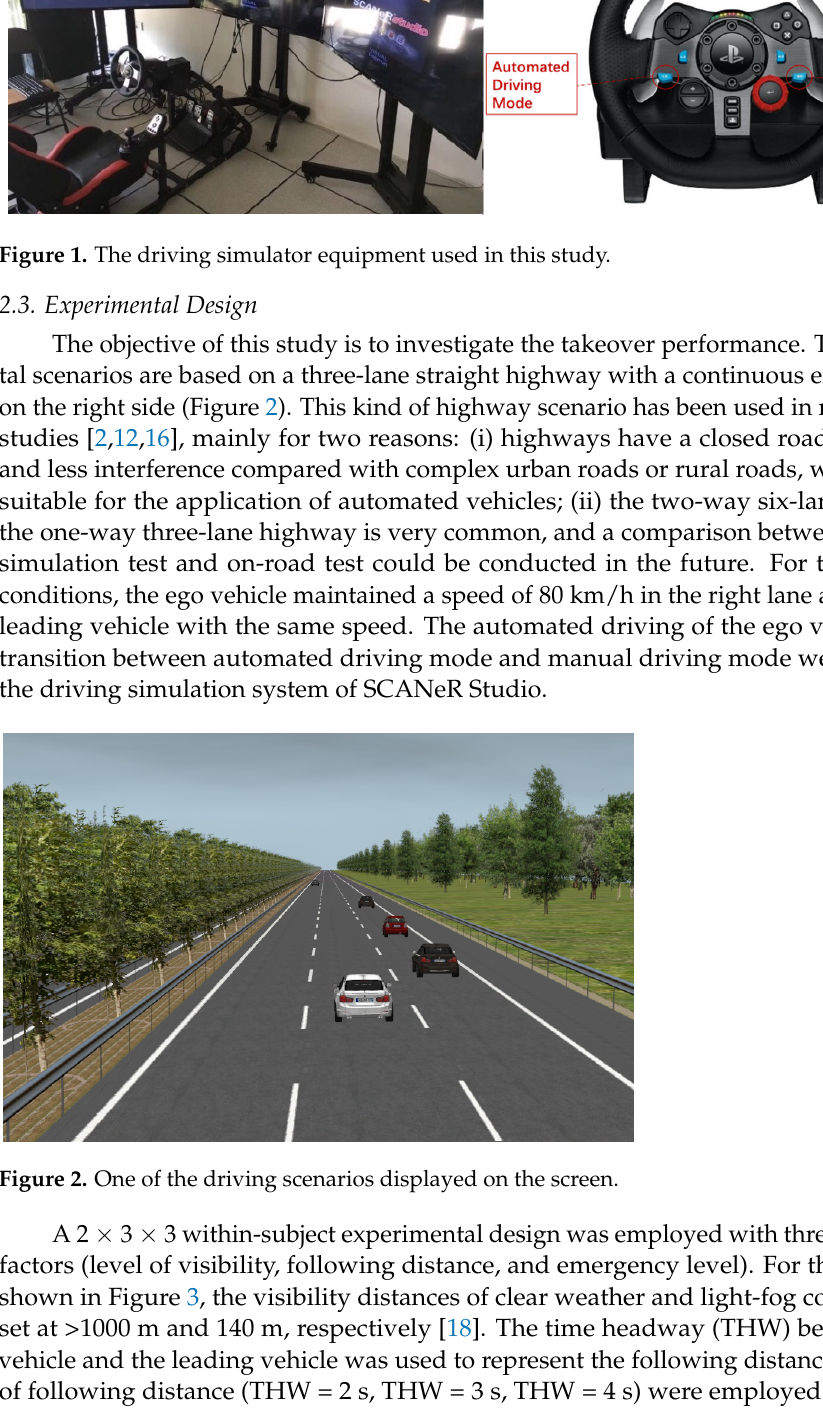
Figure 2. One of the driving scenarios displayed on the screen.